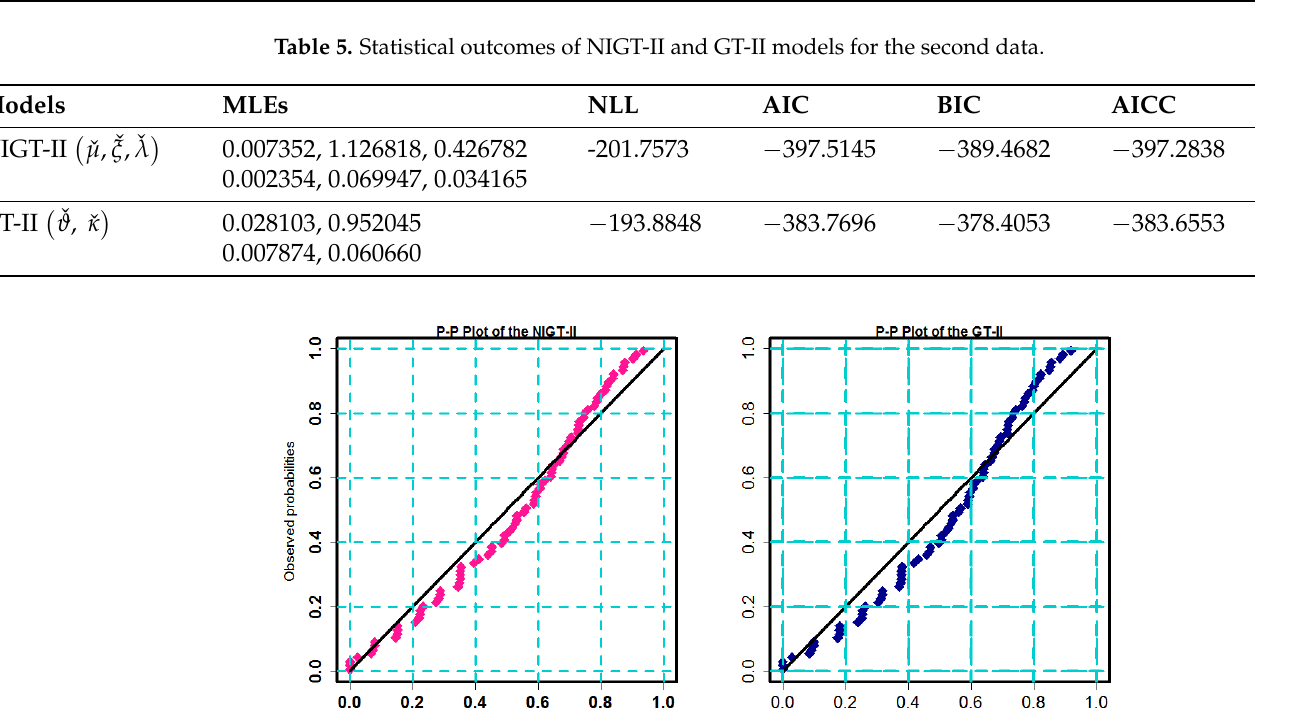
Fig. 8. Probability plots of NIGT-II and GT-II models for dataset II. Closing remarks on both applications 1. NIGT-II has the lowest values of analytical measures of GOF statistics, in accordance with both datasets. 2. As seen in Figs. 7 and 8 NIGT-II is the most e⁄ective model for (cid:133)tting datasets I and II 3. The GT-II distribution demonstrates poor (cid:133)t for the both datasets, as shown in Tables 4-5. 4. Figs. 9 and 10 indicated the existence of estimated parameters for the proposed model for the two real data sets, respectively. 5. The log-likelihood function has a global maximum root for the model parameters, as shown in Figs. 9, 10.